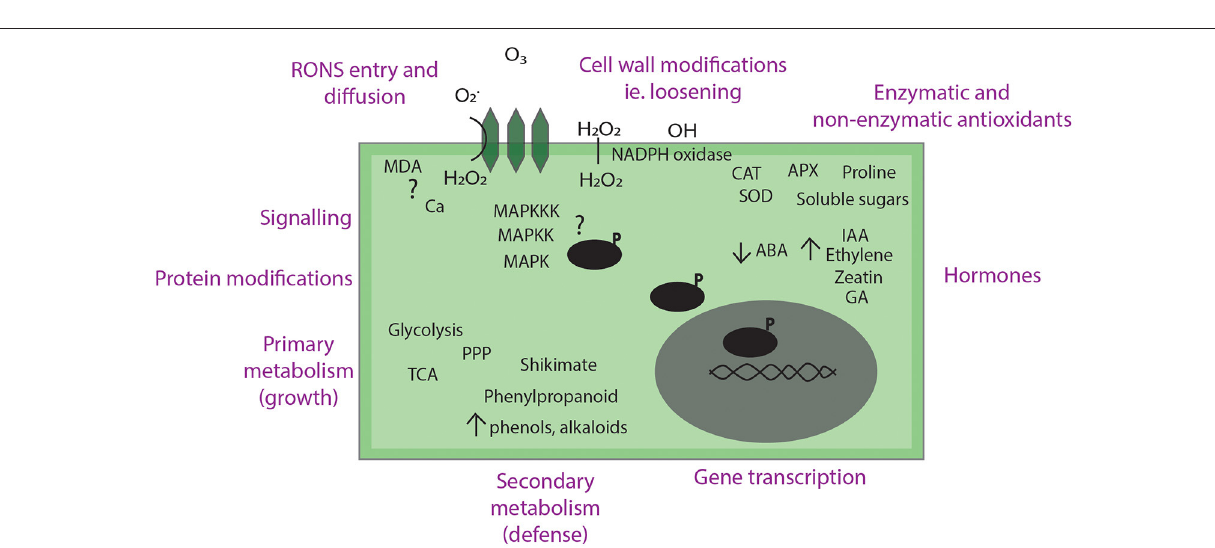
FIGURE 3 | Summary of hypotheses and current evidence of plasma-seed treatments on a molecular